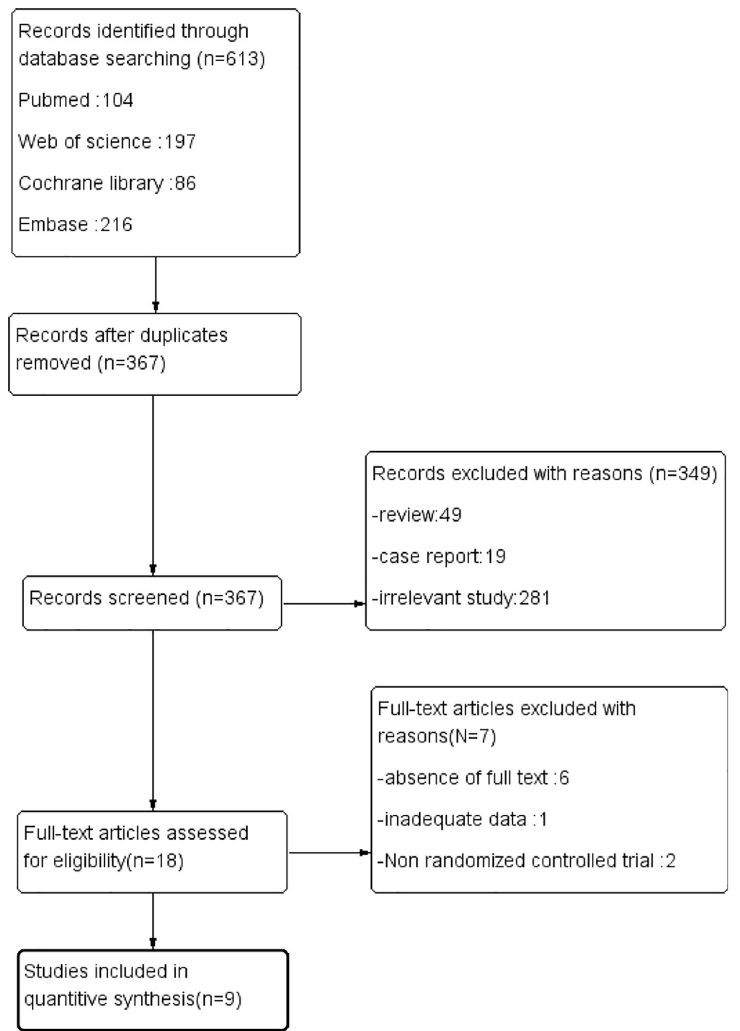
Fig 2. The search, inclusion and exclusion of the